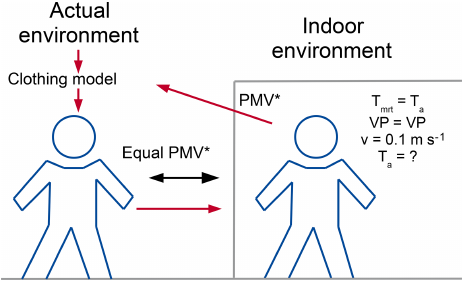
Figure 1. Schematic overview of the comparison of adjusted pre- dicted mean vote (PMV) between the actual prevailing environ- ment and a virtual indoor environment for the estimation of the perceived temperature. The sample human is standardized by the “Klima-Michel” model.